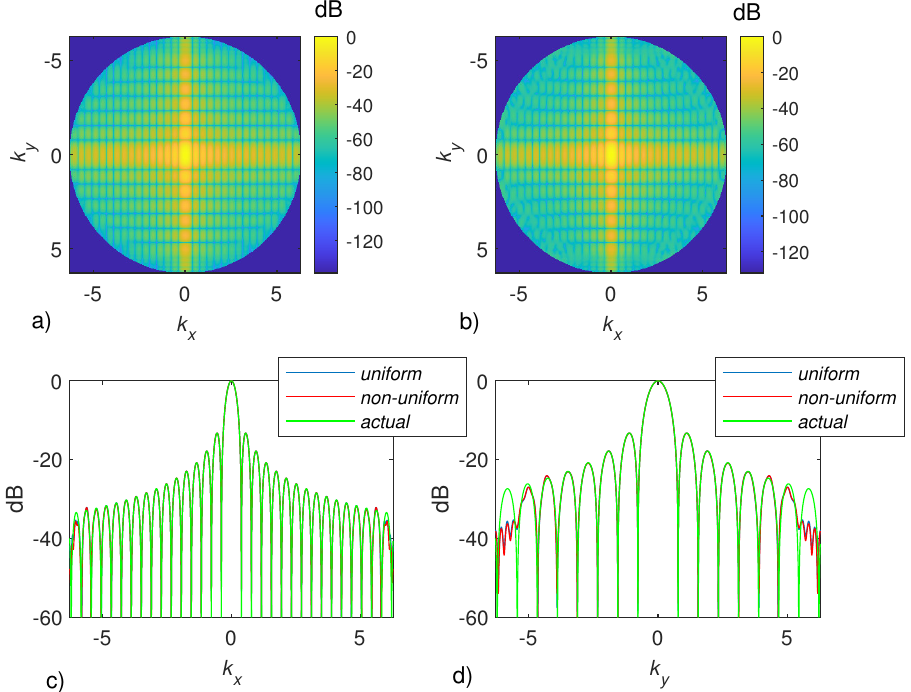
Figure 7. Normalized amplitude of the radiation pattern of J 2 ( x , y ) with X s = 8 λ , Y s = 4 λ , z o = 7 λ , X 0 = 30 λ and Y 0 = 15 λ . In ( a ), the radiation pattern is obtained by employing the near-field data according to the proposed non-uniform sampling scheme over the grid shown in ( b ) of Figure 2 and then interpolated over a λ /2 grid. In ( b ), the radiation pattern is obtained by directly employing the near-field data over a uniform λ /2 grid. Panels ( c , d ) have been obtained by fixing k y = k sin ( π /20 ) sin ( π /4 ) and k x = k sin ( π /20 ) cos ( π /4 ) , respectively, and compare the radiation pattern cut-views passing through the main-beam maximum. The green lines refer to the actual radiation pattern, the blue lines to the radiation pattern computed by using the uniform λ /2 sampling and the red ones show the radiation pattern obtained by the proposed method. Noiseless